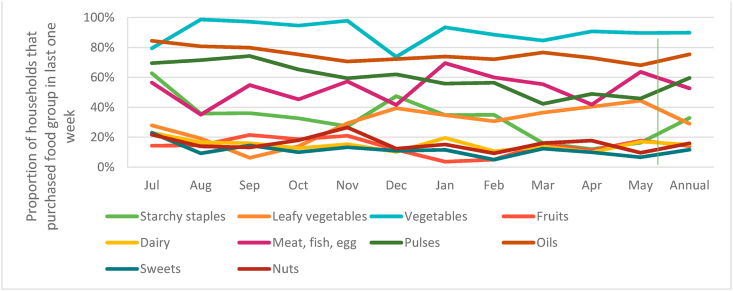
Household reliance on markets for food purchases